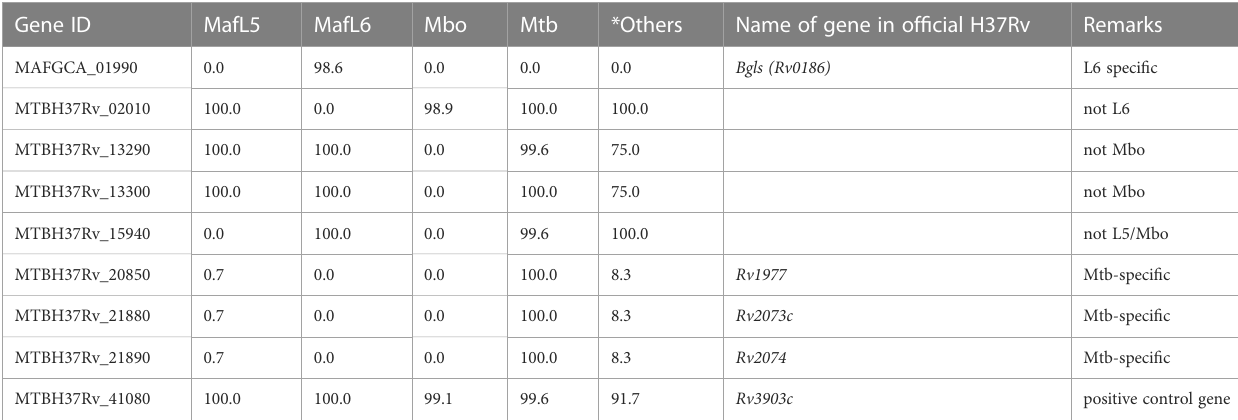
TABLE 2 Summary of Abricate BLAST results showing MTBC lineage-speci fi c